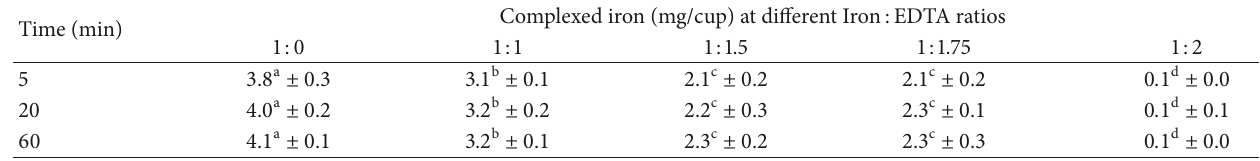
Table 2: Iron (mg/cup) forming complex at different iron :EDTA ratios at tea